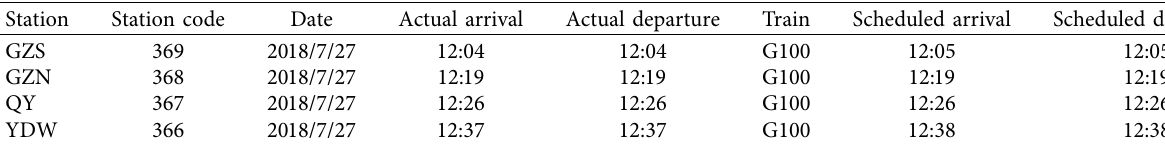
Figure 3: The flowchart of ELM-PSO method. Table 1: Train operation data format in the database.